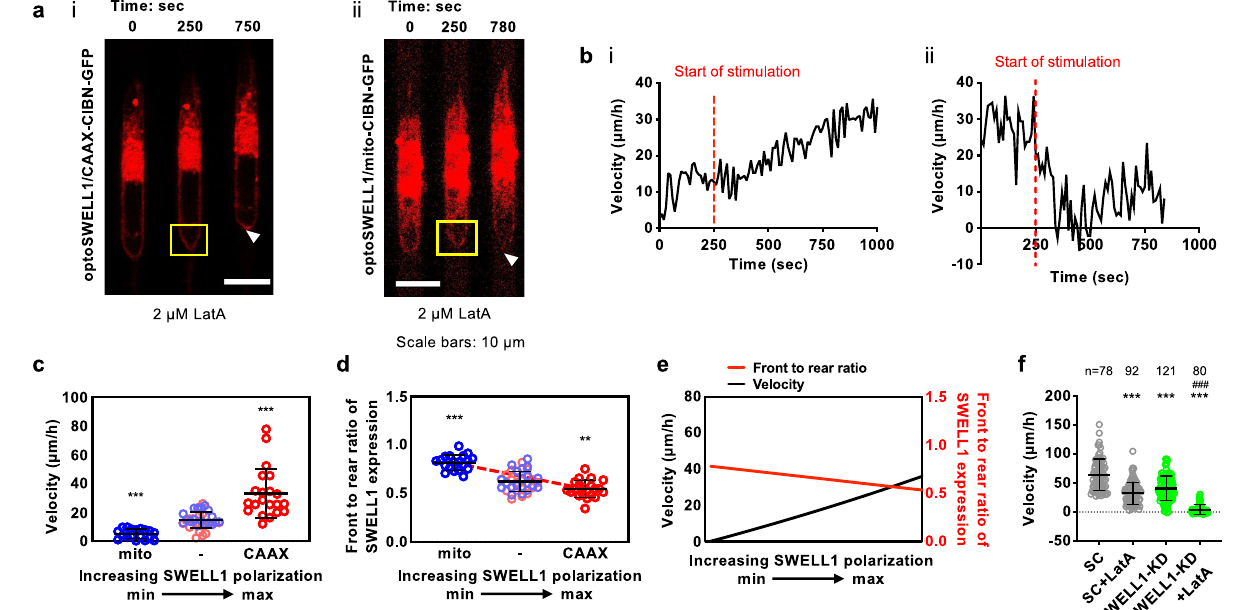
Fig. 3 | SWELL1 polarization regulates OEM-based, F-actin-independent migration inside stiff, con fi ning channels. a Representative montage of MDA- MB-231cellsexpressingOptoSWELL1and(i)CAAX-CIBN-GFPor(ii)mito-CIBN-GFP inside con fi ning channels in the presence of 2 µ M LatA. Optogenetic stimulation was initiated in a region enclosed by the yellow box at the cell rear just after t=250sec, resulting in either SWELL1 enrichment (i) or depletion (ii) at ≥ 750sec. b (i, ii) Instantaneous migration velocities of cells shown in a (i, ii) as a function of time. c Migration velocity and d front to rear ratio of SWELL1 intensity of LatA- treated MDA-MB-231 cells before ( − ) and after optogenetic stimulation. Data